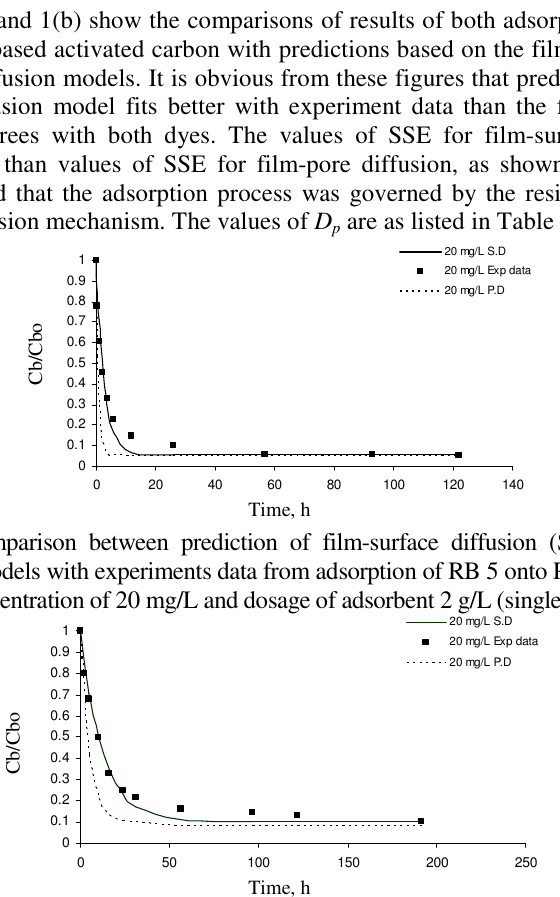
Figure 1(b). Comparison between prediction of film-surface diffusion (S.D) and film-pore diffusion (P.D) models with experiments data from adsorption of RR E onto PKS-based activated carbon at dye concentration of 20 mg/L and dosage of adsorbent 2 g/L (single